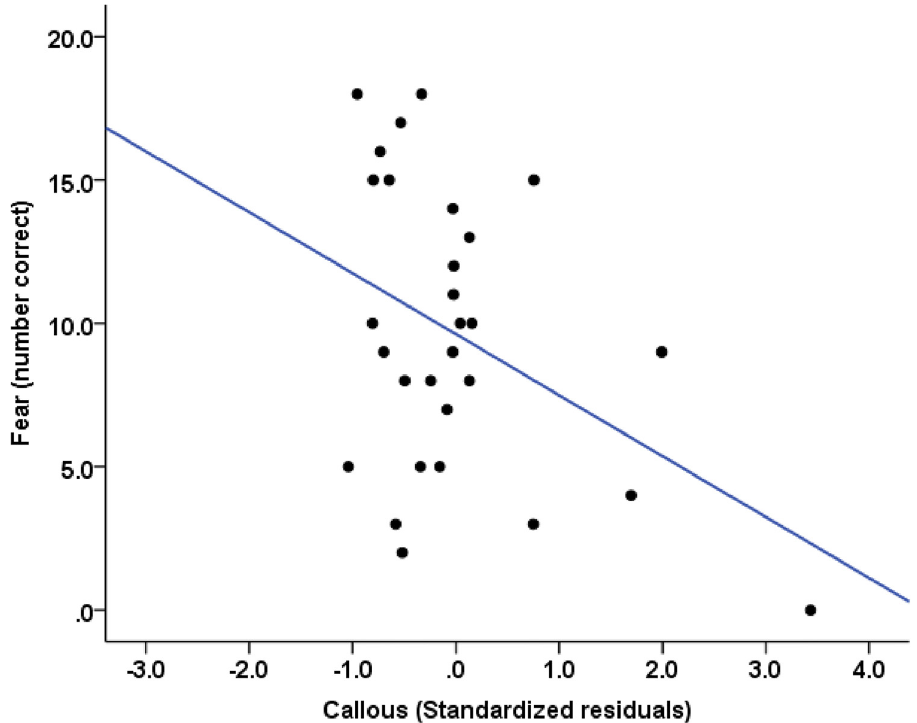
Fig 3. Scatter plot showing the relationship of callous psychopathic traits with accuracy of fearful face